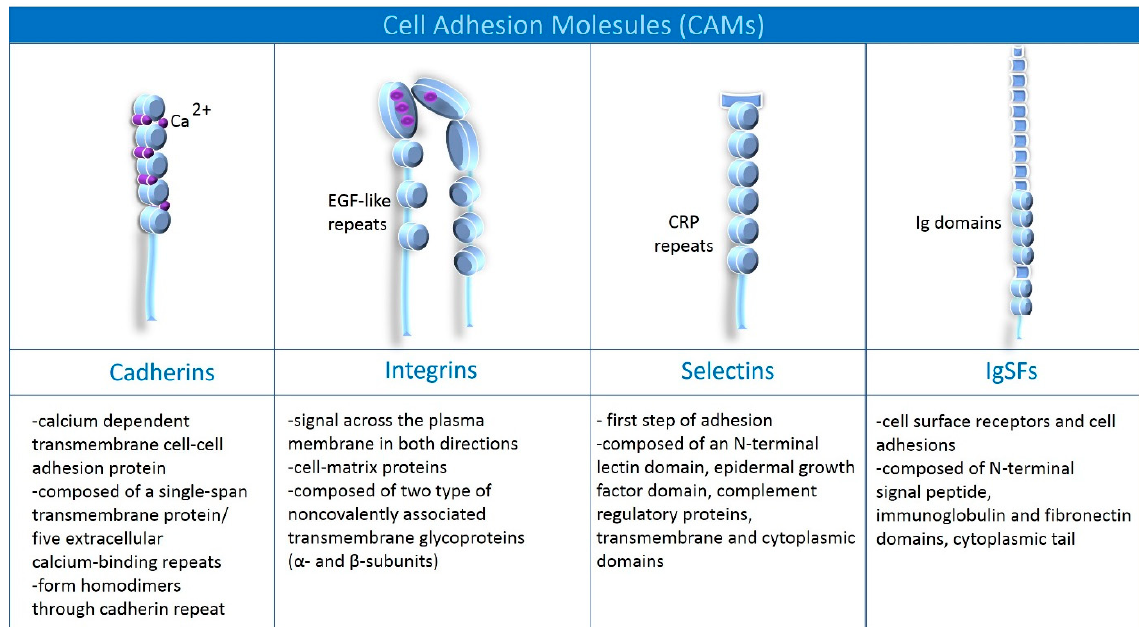
Figure 2. Classification and composition of cell adhesion molecules (CAMs)